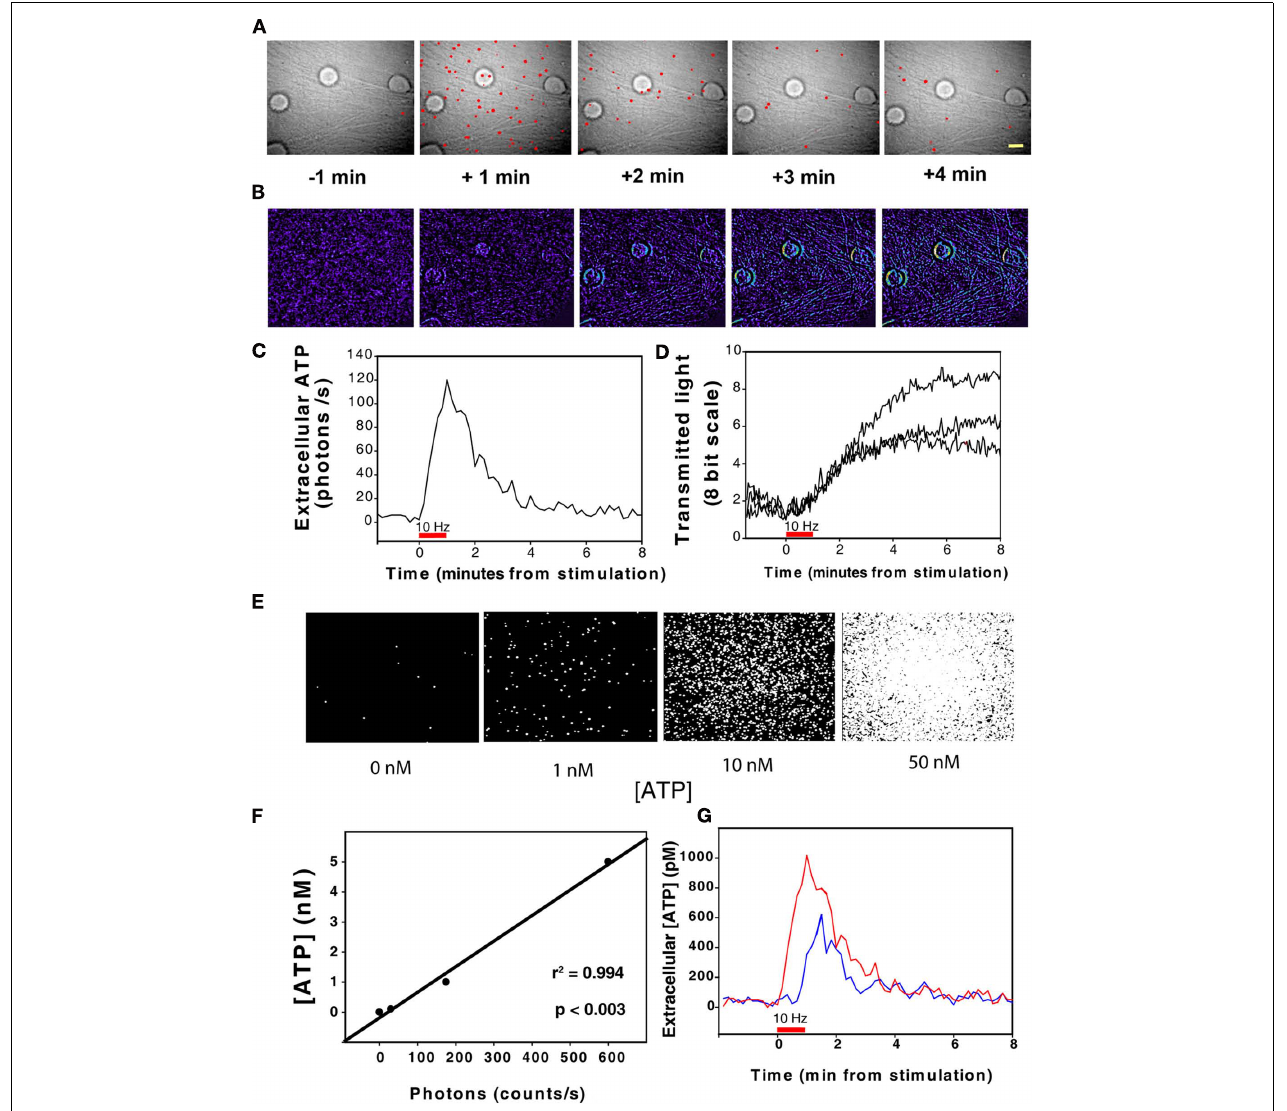
intervals is plotted with respect to stimulus onset. (D) Quantification of the experiment in (B) showing the increase in light transmission through neurons in response to electrical stimulation. Changes in pixel intensity on an 8-bit scale are plotted over time after back-ground subtraction using a pre-stimulus reference image. ATP release [rise to peak as in (C) ] was highly correlated with the increase in light transmission through axons (D) ( p < 0.0001; r 2 = 0.983; n = 12). (E) Single-photon imaging of the luciferin/luciferase reaction provides a quantitative measurement of ATP concentration after calibration against standard ATP solutions.The increase in number of single-photon events is shown in standard solutions of increasing ATP concentrations added to a clean culture dish and imaged as in (A) . (F) The number of single-photon events is linearly related to ATP concentration over a wide range of concentrations. (G) The data in (C) re-plotted after calibration against ATP standard solutions shows that action potentials release ATP to reach concentrations near 1nM (red trace). Action potential-induced ATP release persists in the presence of botulinum toxin (3nM), indicating that ATP is released in part by non-vesicular mechanisms (blue trace). ATP release was delayed with respect to stimulus onset and the ATP concentration recovered to pre-stimulus levels within several minutes of stopping the